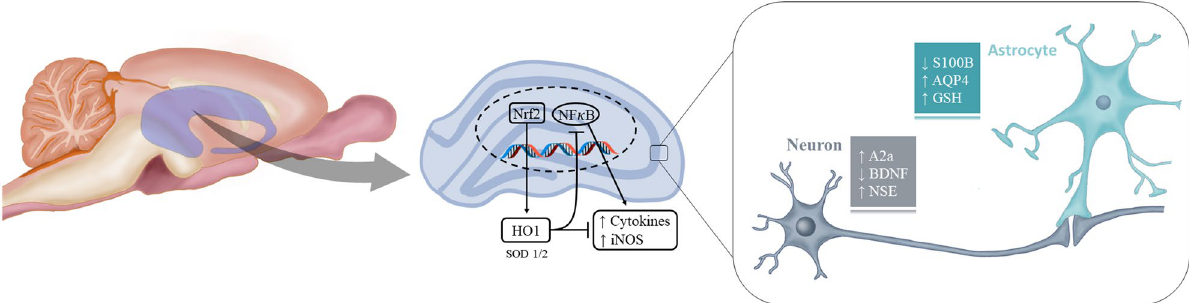
Figure 4. Schematic illustration of some cellular targets of ZIKV in neural cells. Our data reinforce the strong neurotropism of ZIKV, which was able to readily increase the expression and/or release of pro-inflammatory mediators, such as cytokines and iNOS. Inflammatory response is mainly coordinated by NFκB. In contrast, Nrf2 and its transcriptional products, such as HO1, are important regulators of adaptive responses to cellular stresses. HO1 is able to counteract inflammatory response and NFκB transcription activity. However, both Nrf2 and HO1 were downregulated by ZIKV exposure. More specific neuronal and astroglial ZIKV-induced effects could also be observed. A decrease in BDNF release, an increase in NSE and in A2a receptor gene expression can be mainly attributed to neurons (although A2a can be also expressed by astrocytes and microglia). Moreover, a decrease in S100B release, as well as an increase in mRNA levels of AQP4 and in GSH content can indicate an acute ZIKV-induced glial commitment in the hippocampus of adult